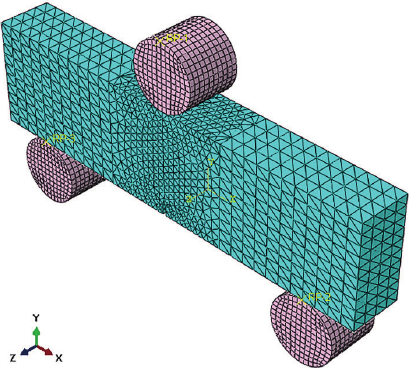
Fig. 18. Finite element model of the three-point bending beam with